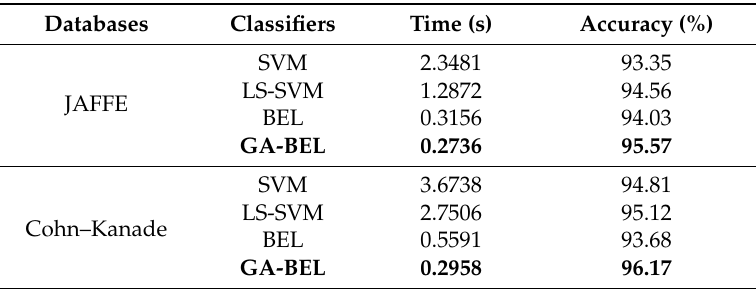
Table 8. The performance comparisons of different